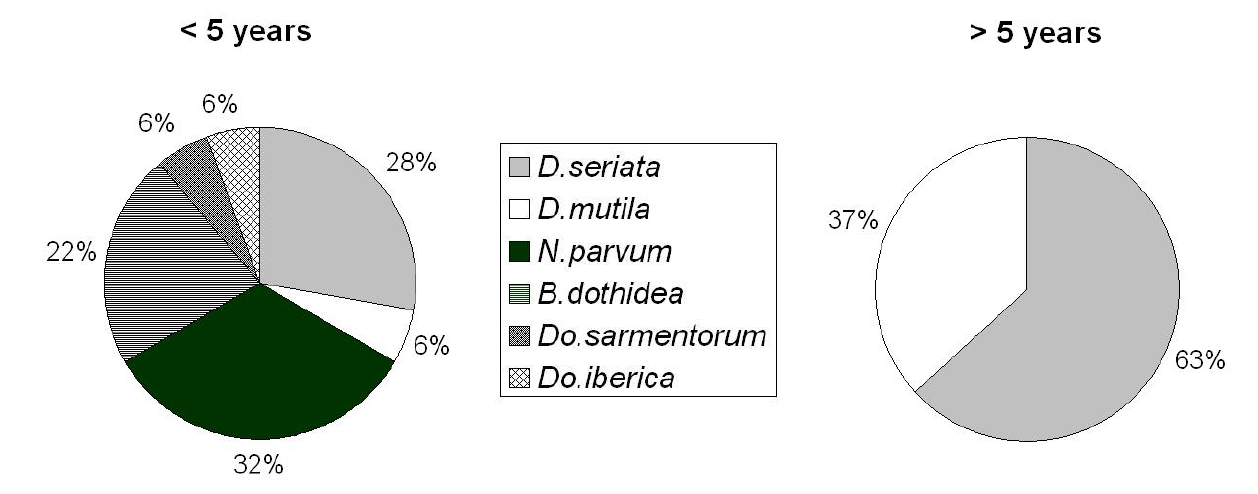
Fig. 4. Percentages of Botryosphaeria -like species identified in young and adult